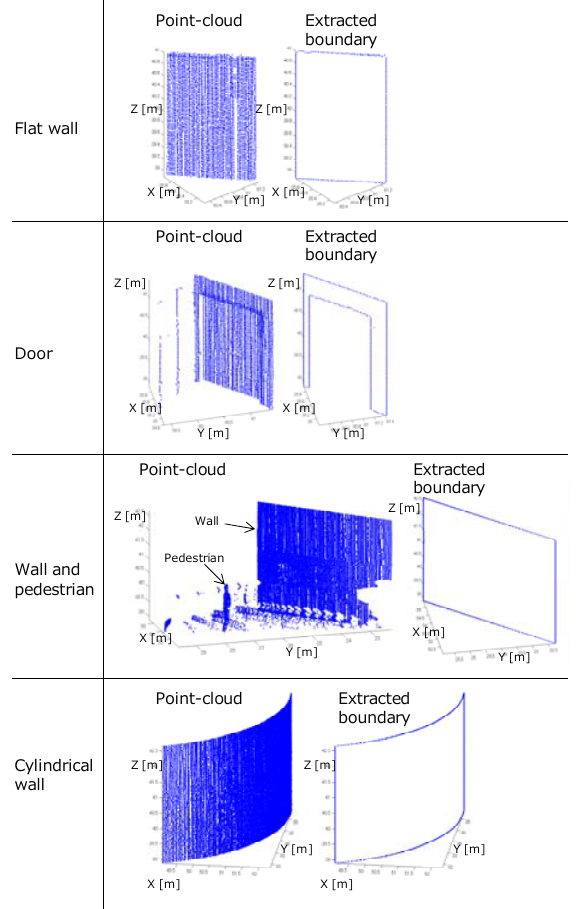
Figure 12. Parts of results of polygon extraction from point cloud